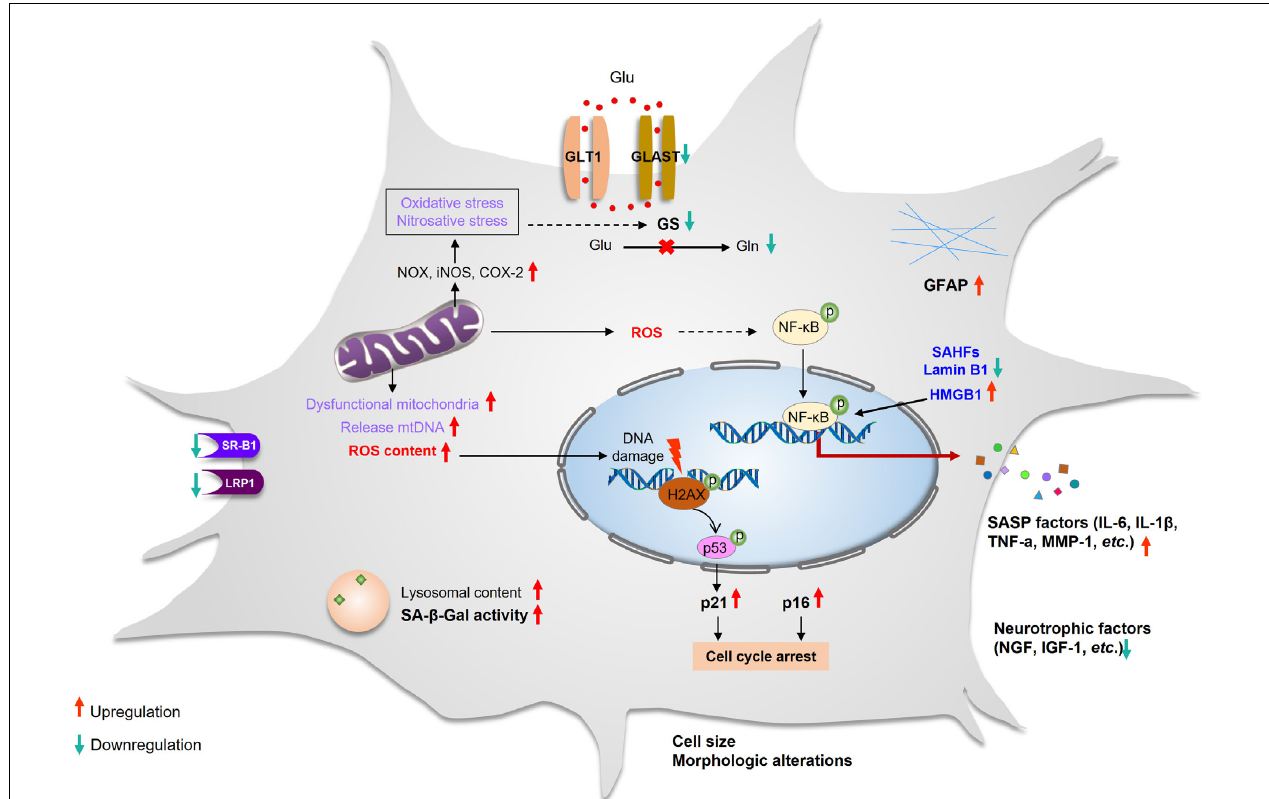
FIGURE 1 | Characteristics of astrocyte senescence. Senescent astrocytes that have undergone cell cycle arrest and have enlarged sharply. The expression of GFAP increased, whereas the expression of glutamate transporters (GLAST and GS) and SR-B1 and LRP1 decreased. The lysosomal content has increased, and the lysosomes have high β -galactosidase activity and dysfunctional mitochondria that produce high levels of ROS and release mtDNA. They have DNA damage and SAHFs, and their nuclear integrity is compromised due to the loss of laminB1. The elevated ROS activates the NF- κ B pathway and promotes SASP production. The secretion of neurotrophic factors is decreased. GFAP, glial fibrillary acidic protein; GLAST, glutamate aspartate transporter; GLT-1, glutamate transporter-1; GS, glutamine synthetase; iNOS, inducible nitric oxide synthase; LRP1, lipoprotein receptor–related protein 1; NOX, NADPH oxidase; ROS, reactive oxygen species; SAHFs, senescence-associated heterochromatic foci; SASP, senescence-associated secretory phenotype; SR-B1, scavenger receptor B1.